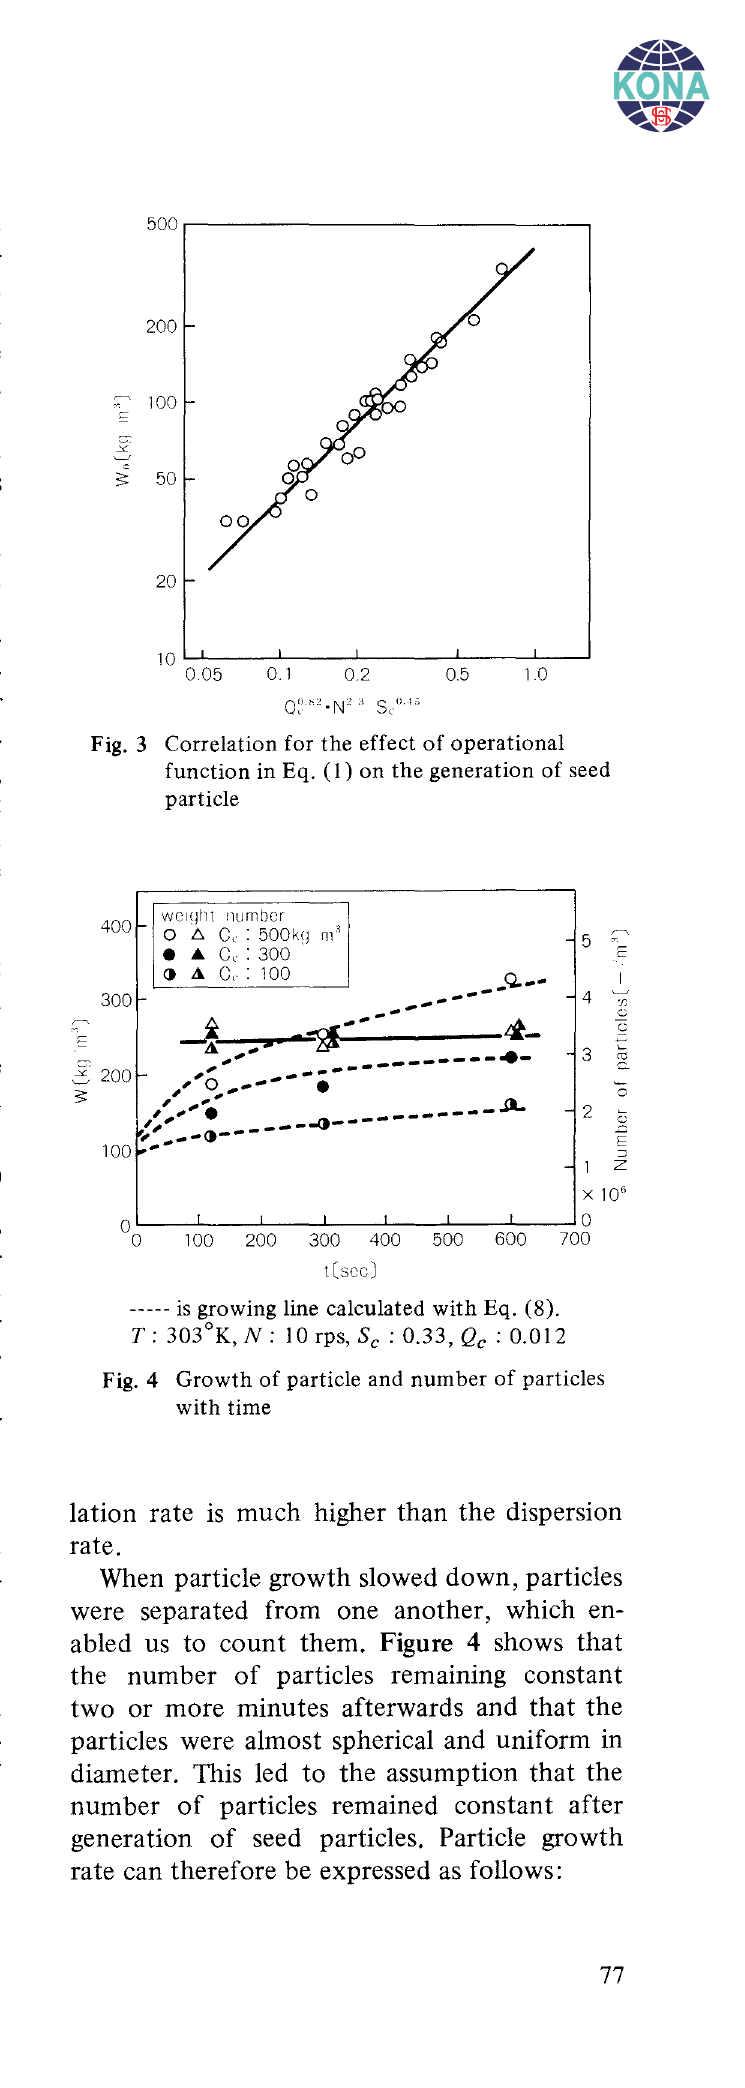
Fig. 3 Correlation for the effect of operational function in Eq. ( l) on the generation of seed particle